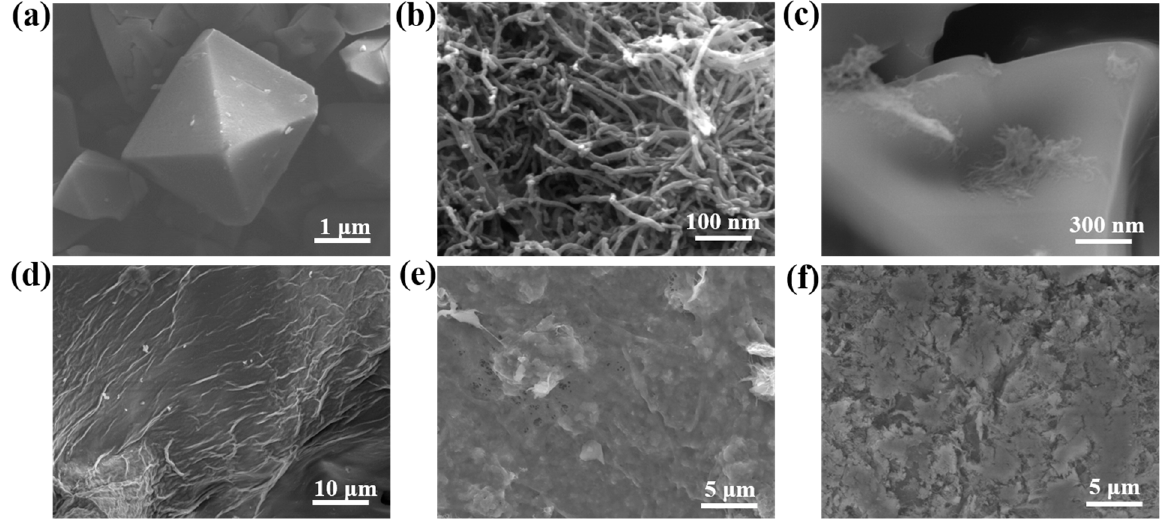
Figure 2. SEM results of: ( a ) Cu-BTC, ( b ) F-CNTs, ( c ) F-C, ( d ) CA, ( e ) C-CA, ( f )